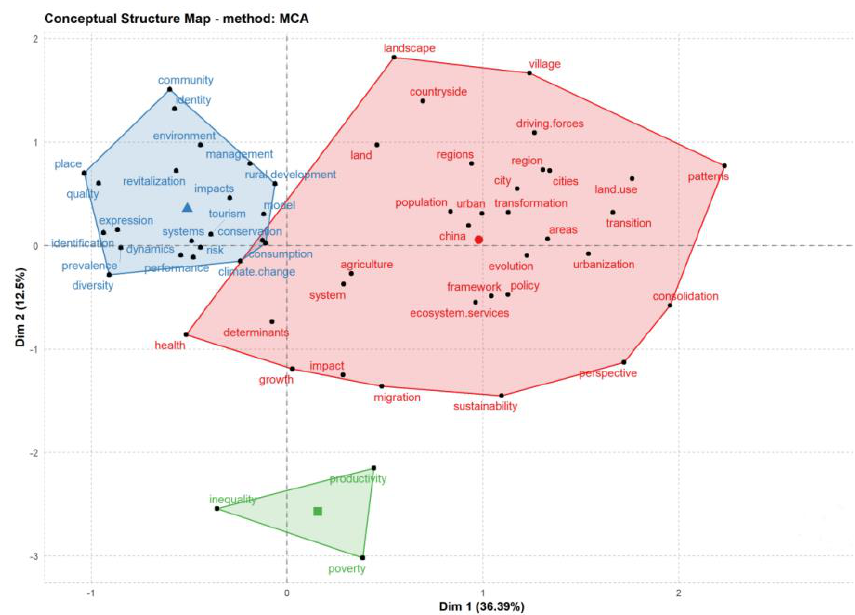
Figure 10. Multiple correspondence analysis of rural revitalization fields.